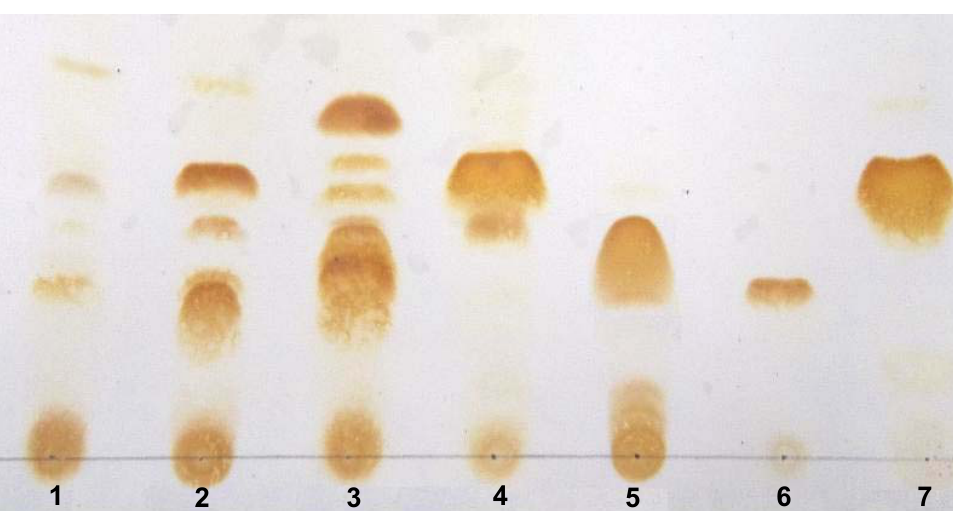
Figure 3. TLC Analysis of Argentinian Amaryllidaceae (BCE). 1 : H. jamesonii , 2 : P. herbertiana , 3 : R. mendocina , 4 : Z. filifolia , 5 : Galanthamine, 6 : Lycorine, 7 :